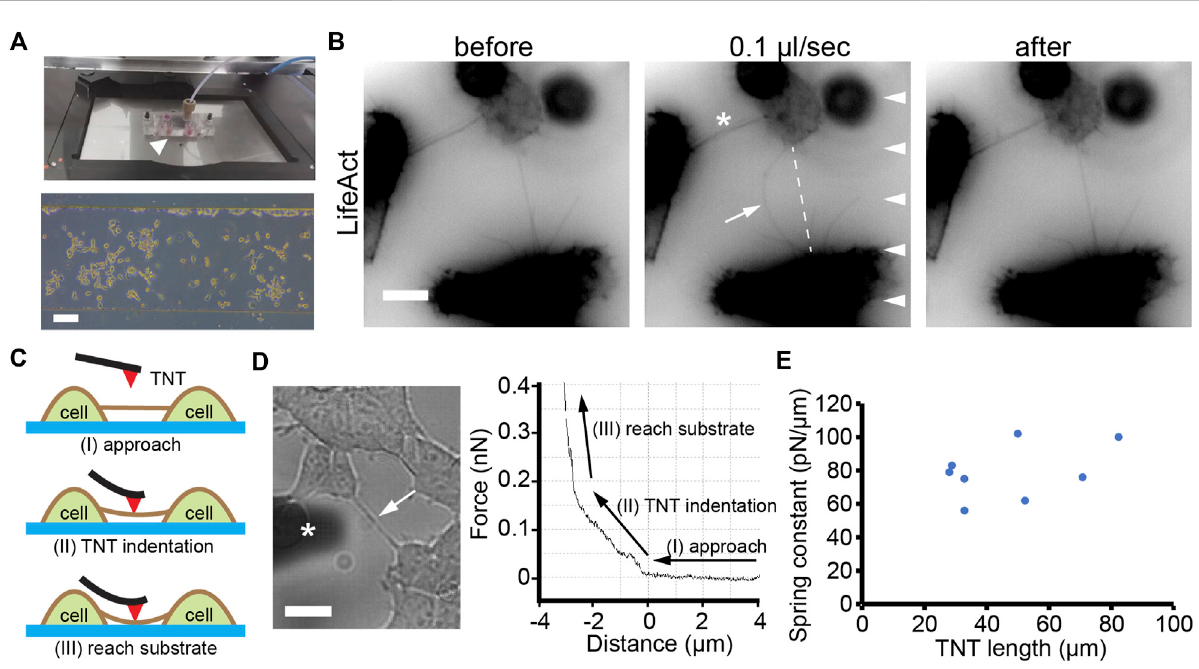
FIGURE 1 ElasticpropertyofTNTs. (A) Top:Micro fl uidicsetup(arrowhead)mountedontothestageofmicroscopy.Bottom:phasecontrastimageofcells after 12 h of culturing inside a micro fl uidic channel. Scale bar, 100 μ m. (B) A TNT (arrow) between two LifeAct-positive HEK293 cells bend when exposedtolaminar fl ow(0.1 μ l/s,arrowheads)andrecoveredwhenthe fl owstopped.NotethattheotherTNT(asterisk)didnotbendduetothesmall angle between the TNTand thedirection of fl ow. Scale bar, 10 μ m. (C) SchematicillustrationoftheAFM indentationexperiment showingthree stages: approach, TNT indentation, and reach substrate. (D) A TNT (arrow, left fi gure) under an AFM cantilever (marked with an asterisk). The force- distance curve includes the three stages. Scale bar, 10 μ m. (E) Apparent spring constants of TNTs with different